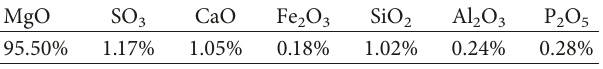
Table 1: Chemical composition of reactive MgO (%).